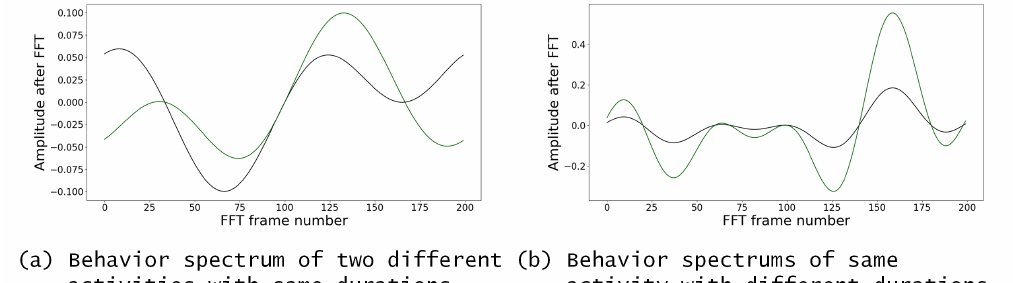
Figure 4. The examples of behavioral spectrum. ( a ) Two different activities performed for the same duration. Here, watching TV and sleeping were set as ID 1 and 2 respectively, and each activity was performed for a duration of 10 min. Therefore, the vector was [ 1 : 10;2 : 10 ] . The black line indicates the user who watched TV (ID 1) for 10 min. The green line shows the user who slept (ID 2) for 10 min; ( b ) is another example of a behavioral spectrum that represents sequencevector [ 1,2 ] with two different durationvectors : [ 10,10 ] and [ 30,30 ] . The amplitude of the behavioral spectrum indicates the duration of activities. The black line shows the user who watched TV before sleeping for 10 min. The green line indicates the activities being performed in the same order, but the duration is 30 min. The difference here is highlighted in the amplitude of the behavioral spectrum.